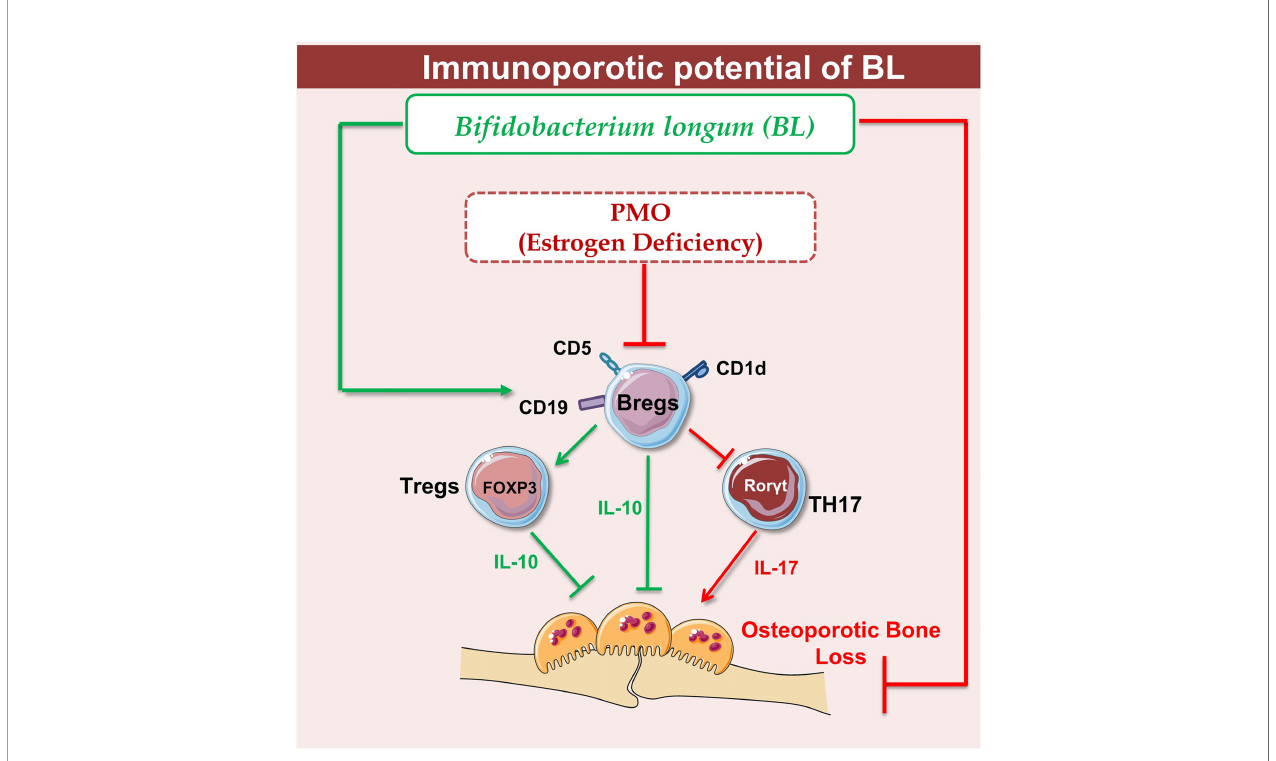
FIGURE 12 | Summary of our results: Under physiological conditions, Bregs and Tregs inhibit osteoclastogenesis via producing the IL-10 cytokine whereas in osteoporotic conditions, dysregulation of the “ Breg – Treg – Th17 ” cell axis promotes bone loss in osteoporotic conditions. Upon BL administration, enhancement of the Bregs population leads to maintenance of homeostatic balance between Tregs and Th17 cells that prevents the bone loss in osteoporotic conditions (image illustrated using Medical Art